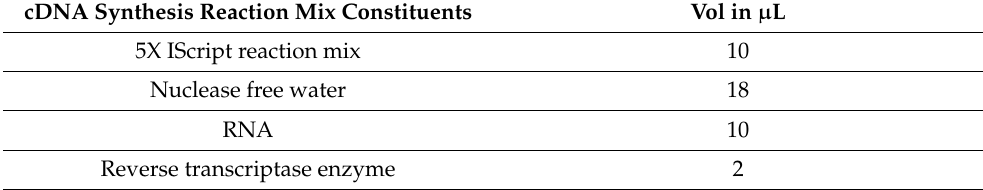
Table 1. cDNA synthesis reaction mix.